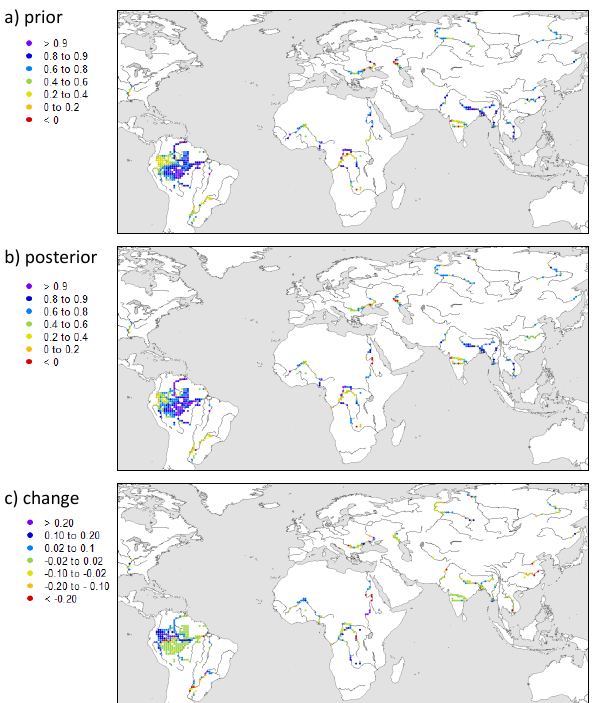
Figure 7. Effect of assimilation agreement with satellite altimetry river water levels: Spearman’s rank correlation coefficient ( ρ ) for (a) prior and (b) posterior estimates and (c) difference between the